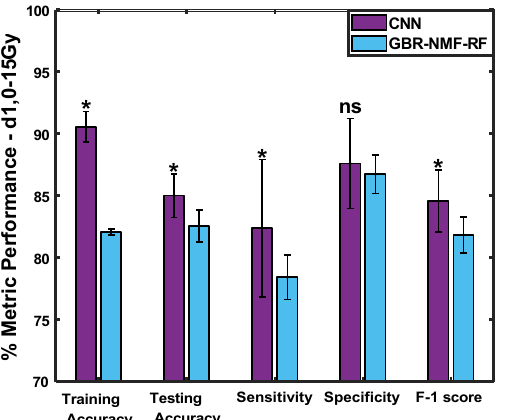
Figure 8. Average training accuracy, testing accuracy, sensitivity, specificity, and F-1 scores for the CNN (violet) and GBR-NMF-RF (blue) models corresponding to the Day 1, 0 and 15 Gy treatment group. *p < 0.05, ns = not